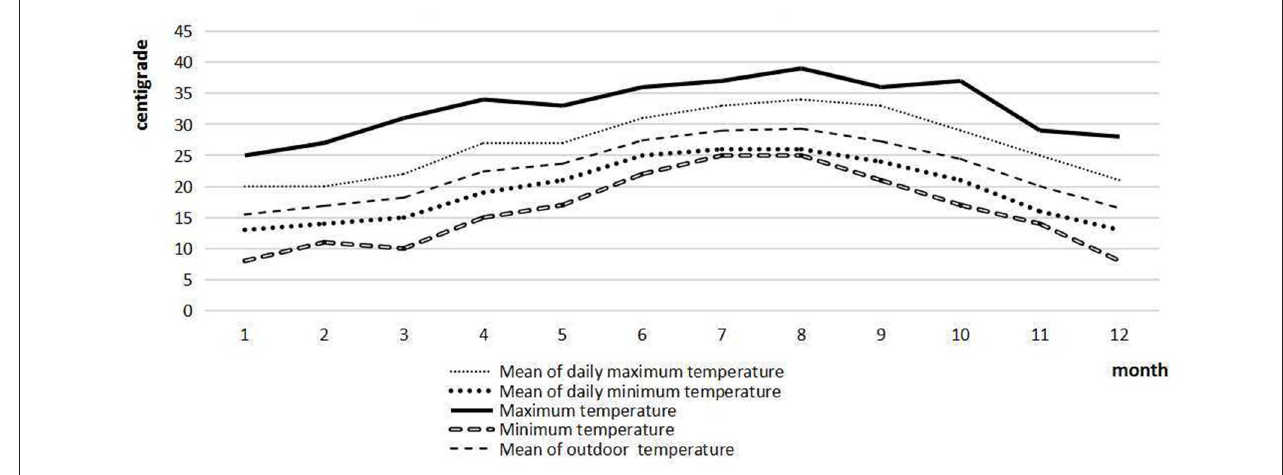
FIGURE 1 | Temperature parameters of Zhangzhou in 2019.